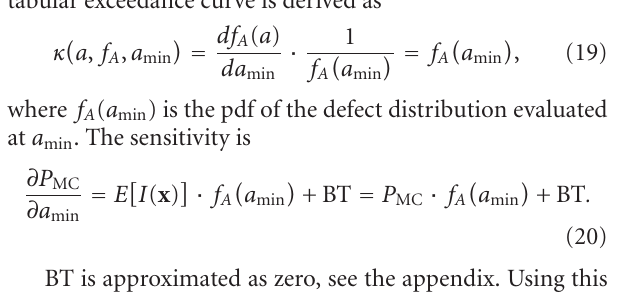
tabular exceedance curve is derived